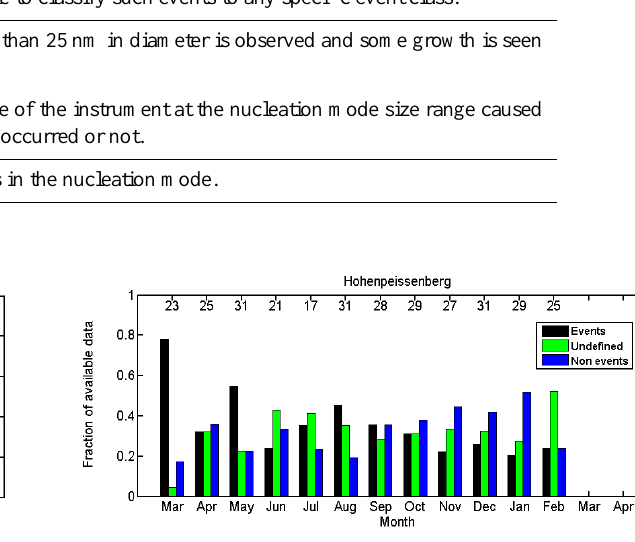
Fig. A5. The fraction of event, undefined and non-event days out of all analyzed days during each month in the year at Cabauw, Netherlands, during April 2008–March 2009.